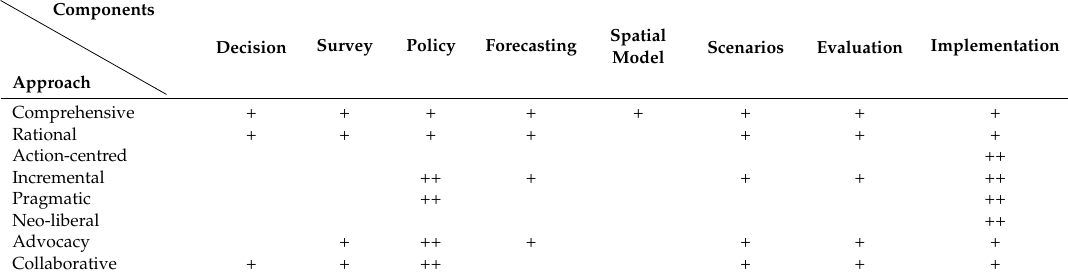
Table 1. The planning components activated by the approaches of the corpus. +: used component. ++: emphasised